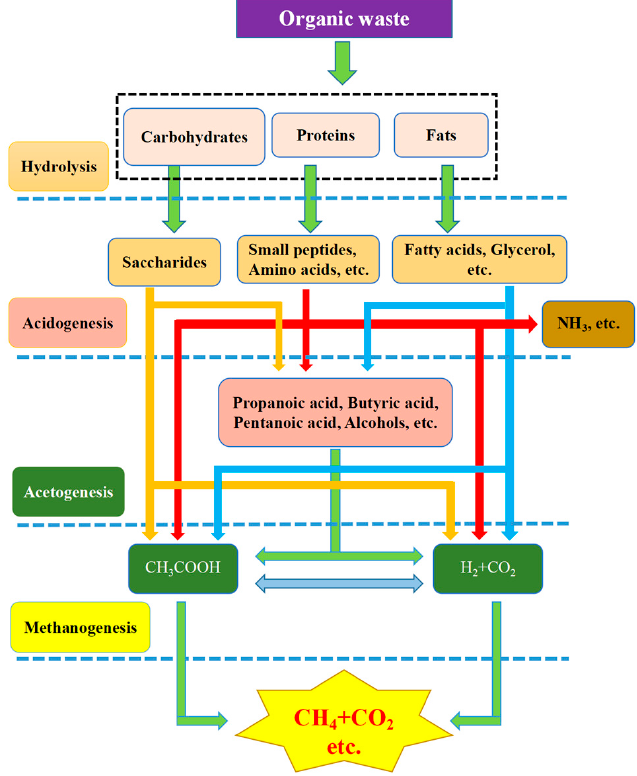
Figure 3. Four-stage theory in the anaerobic digestion of organic waste [47]. Streptococcus , Lactobacillus , Bacillus , Escherichia , and Salmonella are involved in